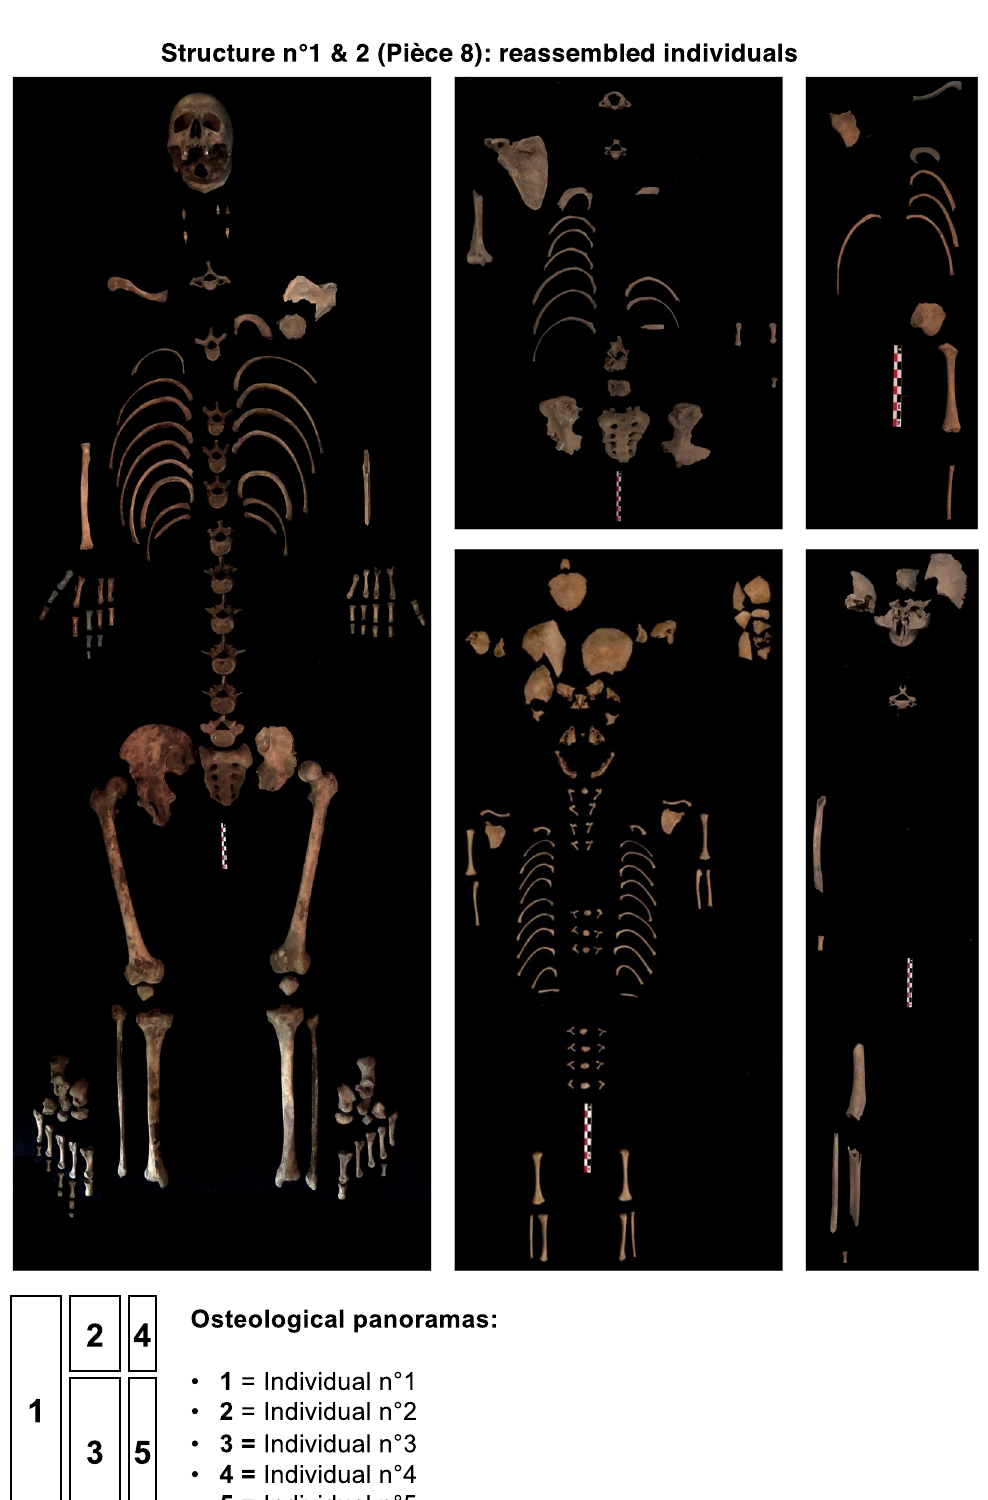
Figure 11: Panoramas of reassembled individuals from Structure no 1 and 2 ( Pièce 8 ) . Photographs by Hofstetter ( 2016 )